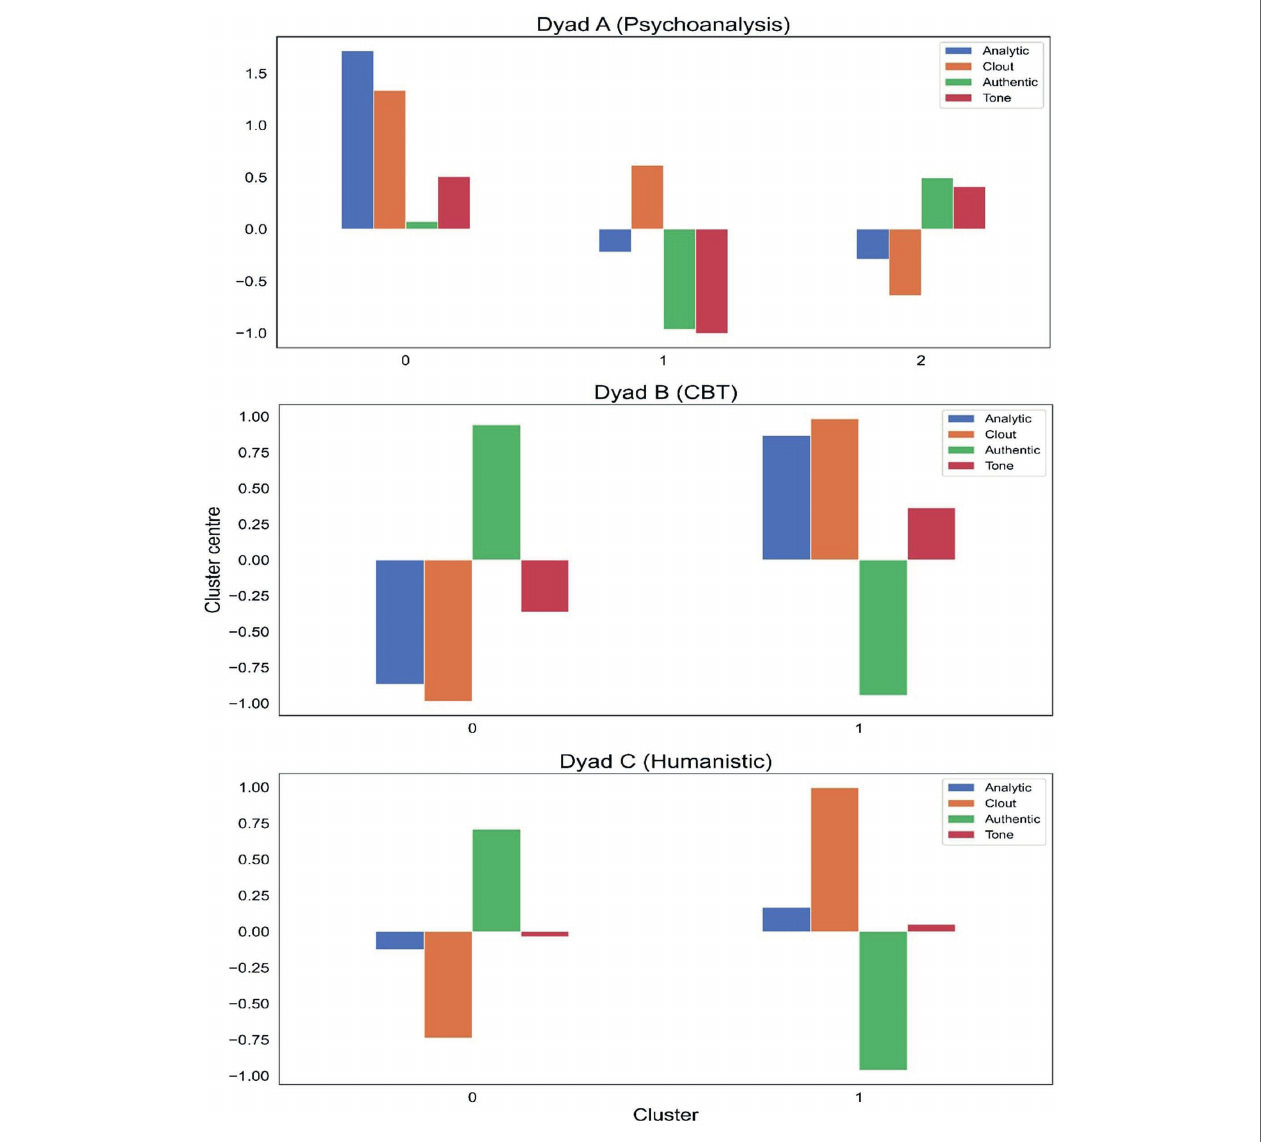
FIGURE 2 | Cluster centers of the three